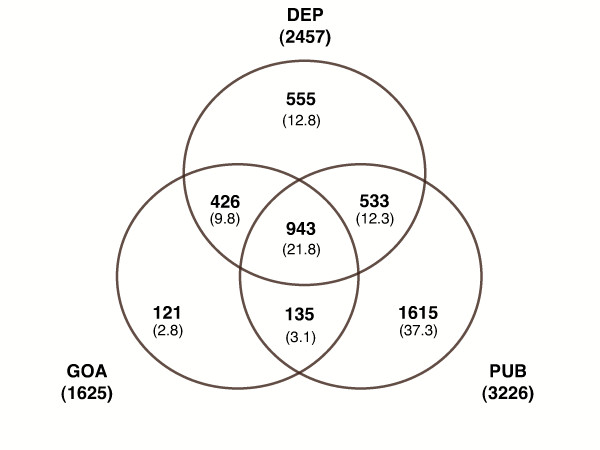
Venn diagram for the reference set. Number of GO Process terms in each category (overall percentage in brackets). Evidence annotation (GOA), Literature annotation (PUB) and Associative relations (DEP).